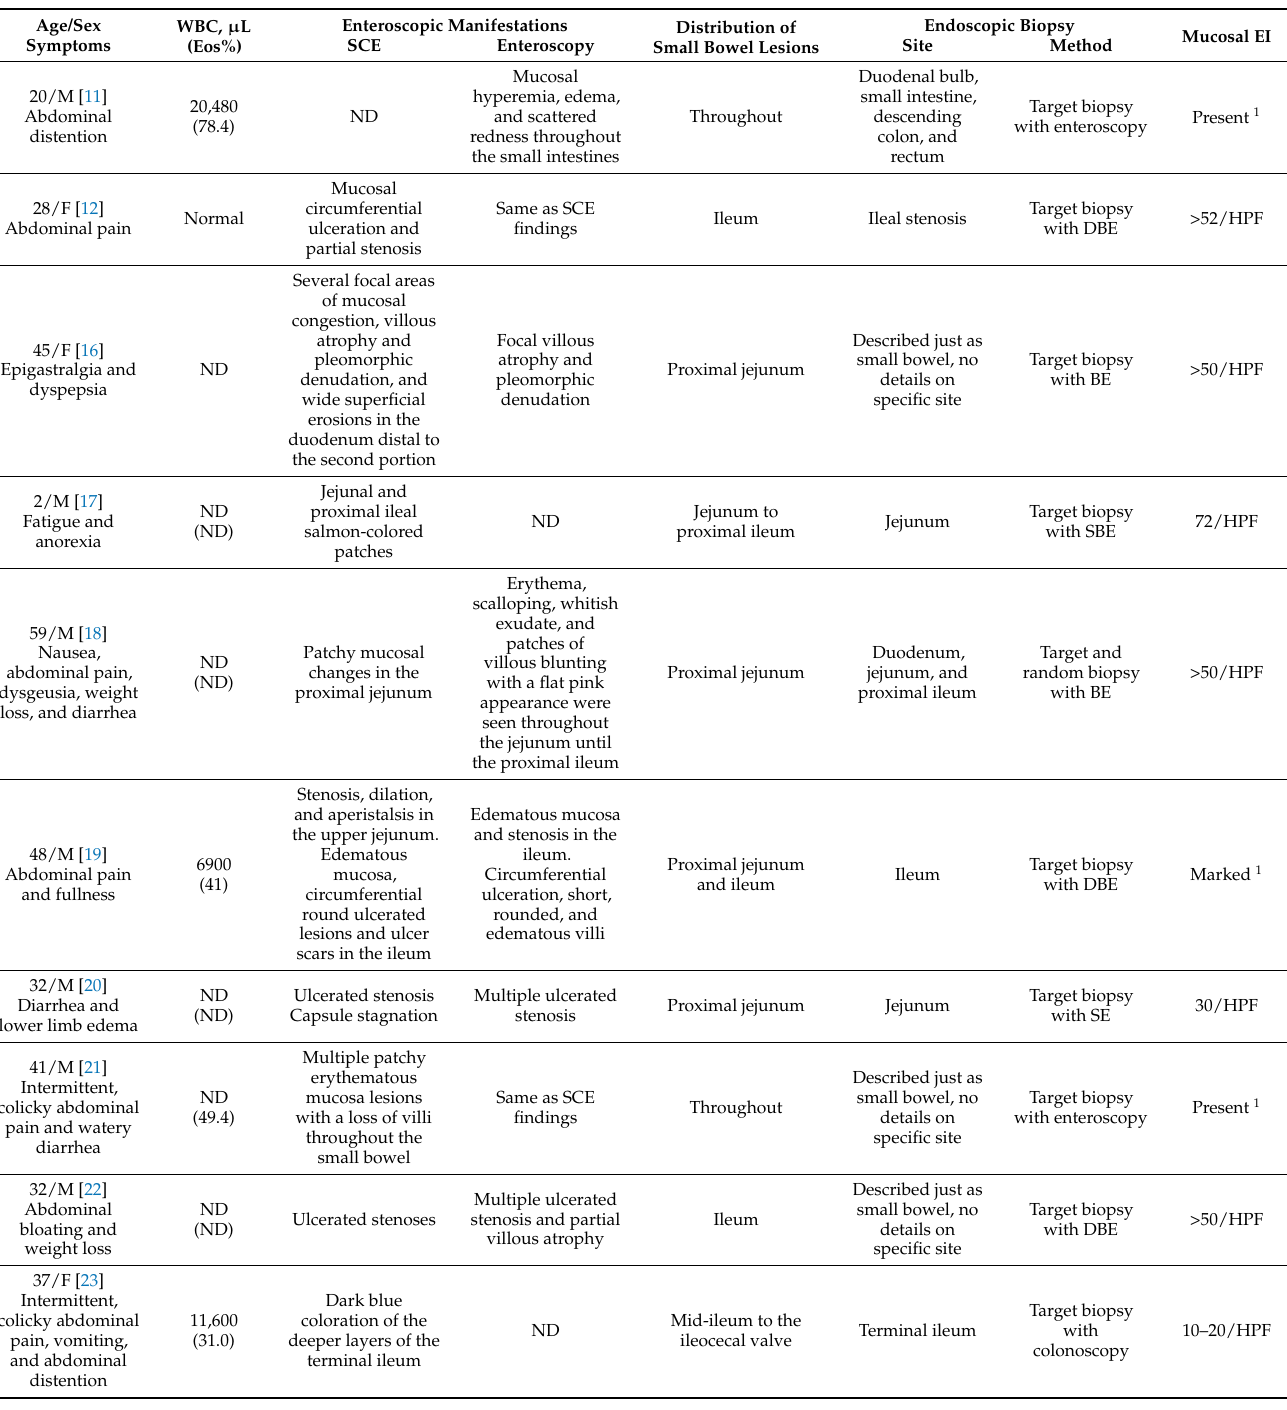
Table 1. Enteroscopic findings of previously reported single case reports of EoGE